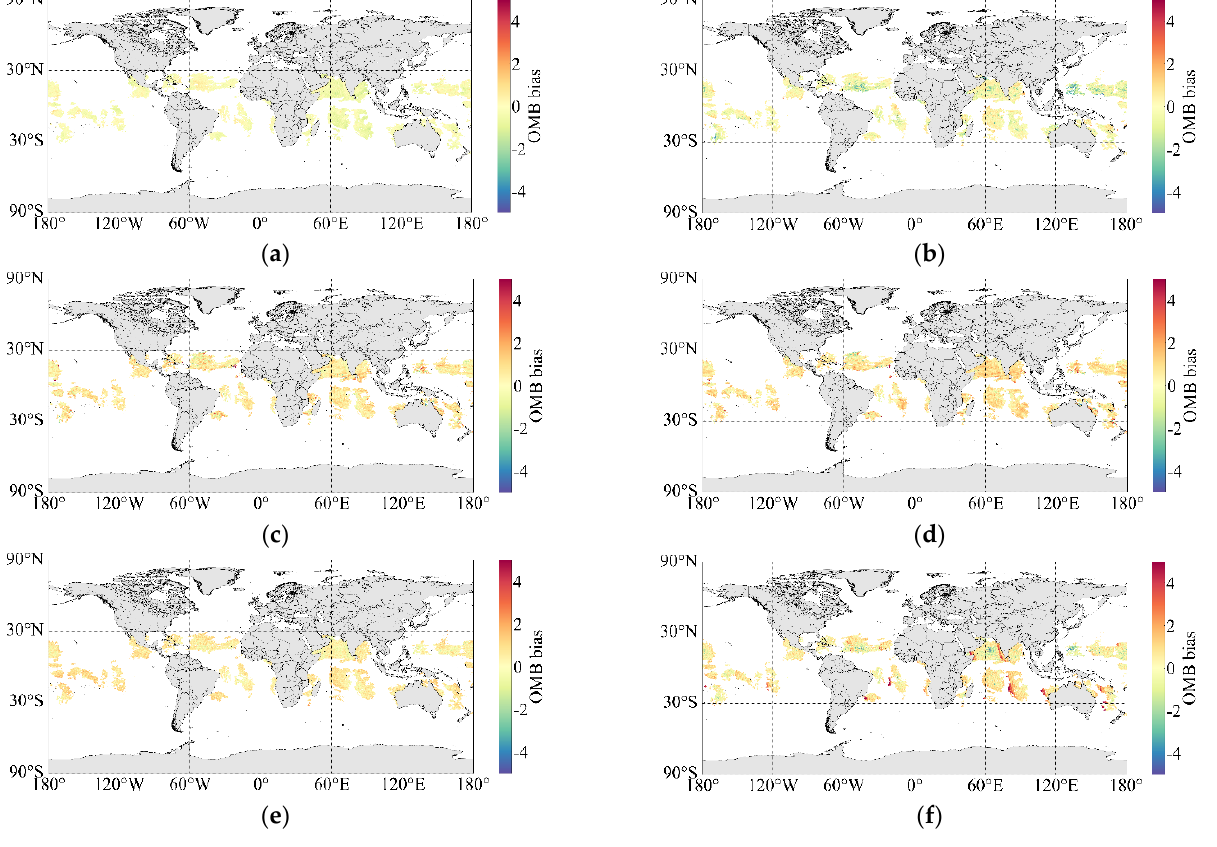
Figure 7. Distribution map of global biased samples: ( a ) 680 cm −1 ; ( b ) 900 cm −1 ; ( c ) 1400 cm −1 ; ( d ) 1600 cm −1 ; ( e ) 2200 cm −1 ; and ( f ) 2500 cm −1 .